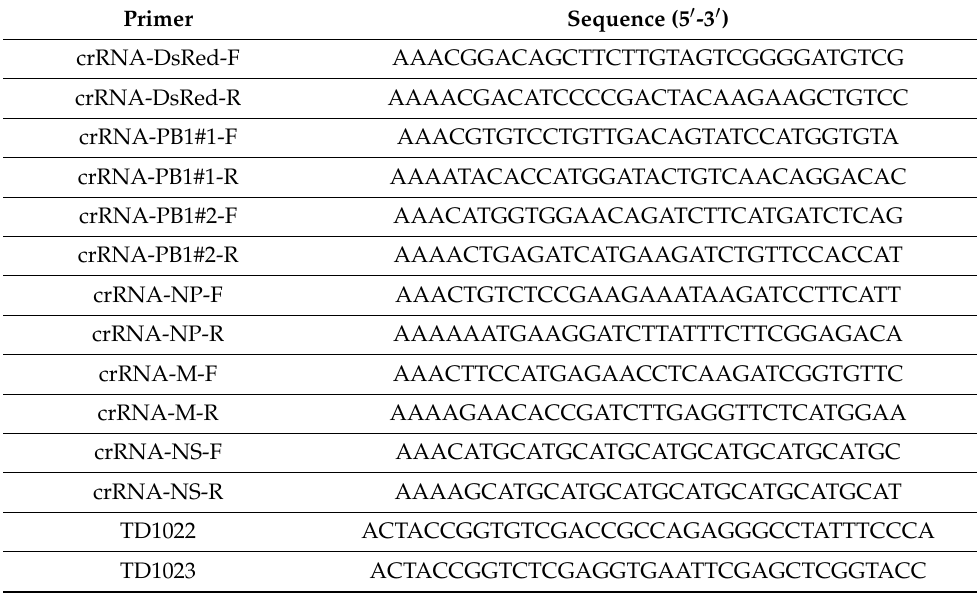
Table 2. List of primers used in the study.